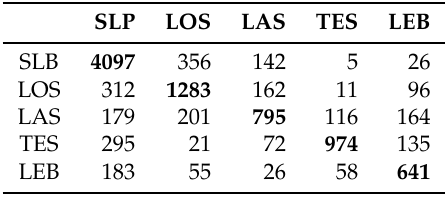
Table 7. Confusion matrix of all subjects.